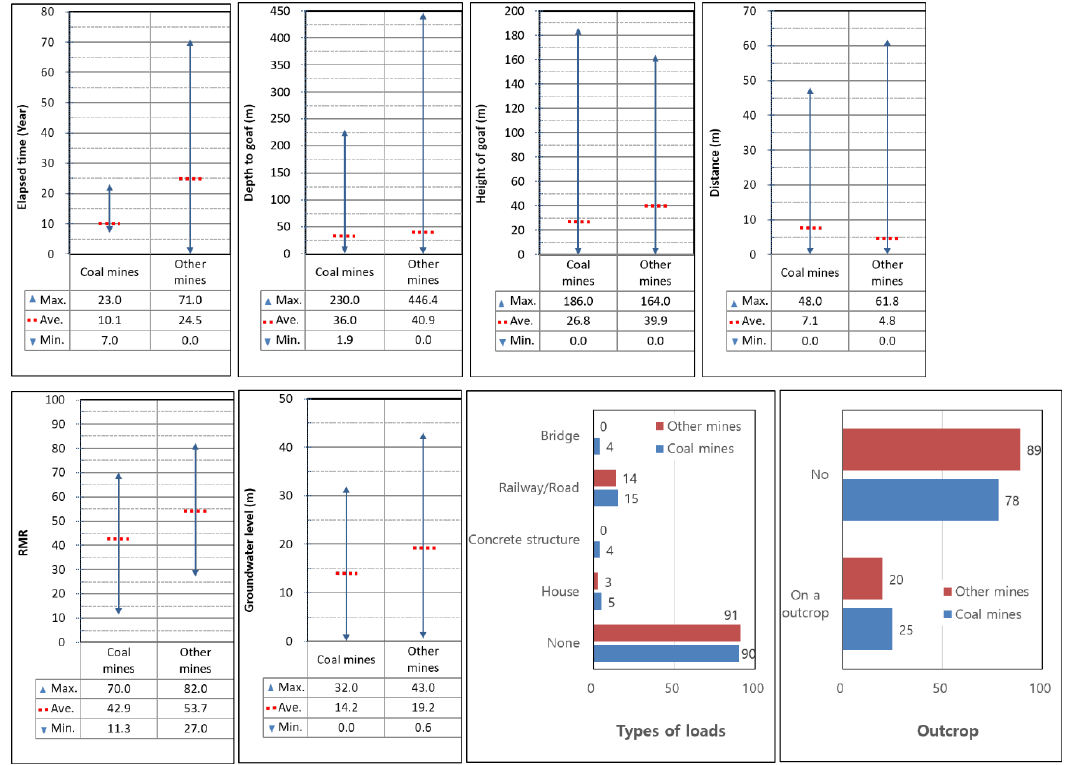
Figure 9. Ranges of investigated data for each factor.